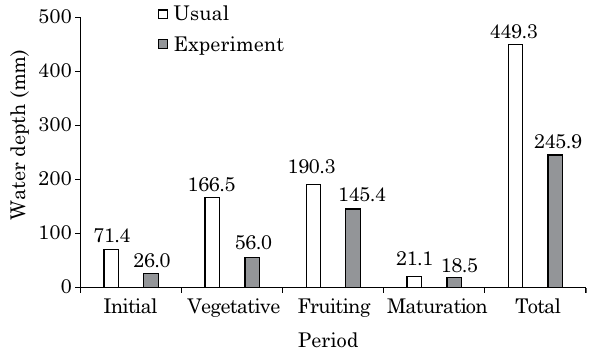
Figure 3. Usual water depths for muskmelon cultivation in the apodi plateau and those applied in the experimental